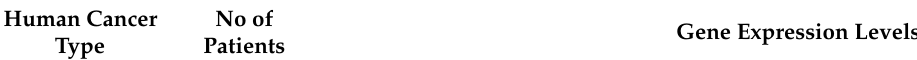
Table 1. IL-37 and SIGIRR mRNA expression levels (FPMKs) in various human cancer types. Data analyzed were obtained from www.proteinatlas.org [31] (accessed on 24 August 2022). p -Values compared to total lung or LUAD specimens using non-parametric Mann - Whitney U test are re- Table 1. Cont. ported.